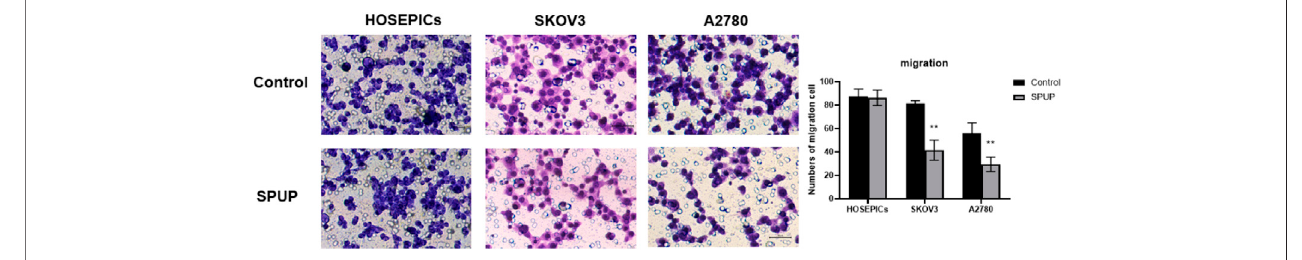
FIGURE3| Effect ofSPUPon themigrationabilityoftwokindsofOCcellsandhumannormal ovarianepithelialcells.Comparedwiththecontrolgroup, ** p < 0.01.